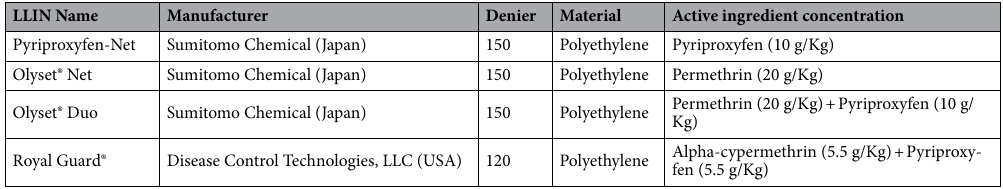
Table 1. Manufacturer and insecticide information for